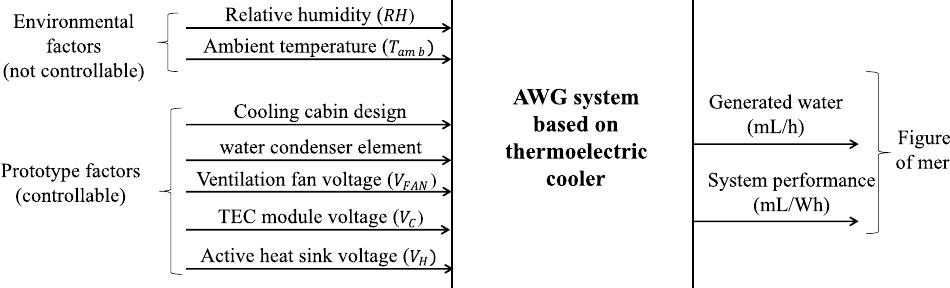
Figure 3. Factors affecting water generation in an Atmospheric Water Generator (AWG) system based on a thermoelectric